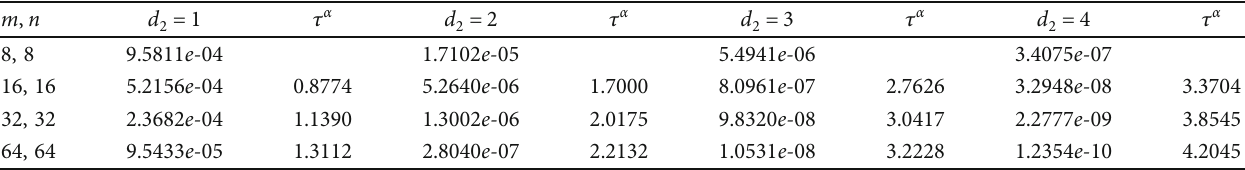
= 7 at t = 1 for equidistant nodes. 1